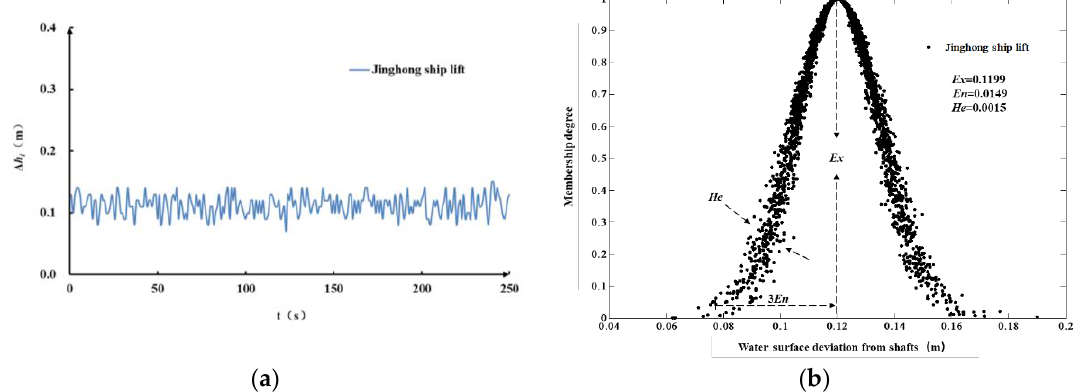
Figure 11. Water surface deviation from the shafts in Jinghong ship lift: ( a ) the diagram of water surface deviation from the shafts and ( b ) the cloud model expression.